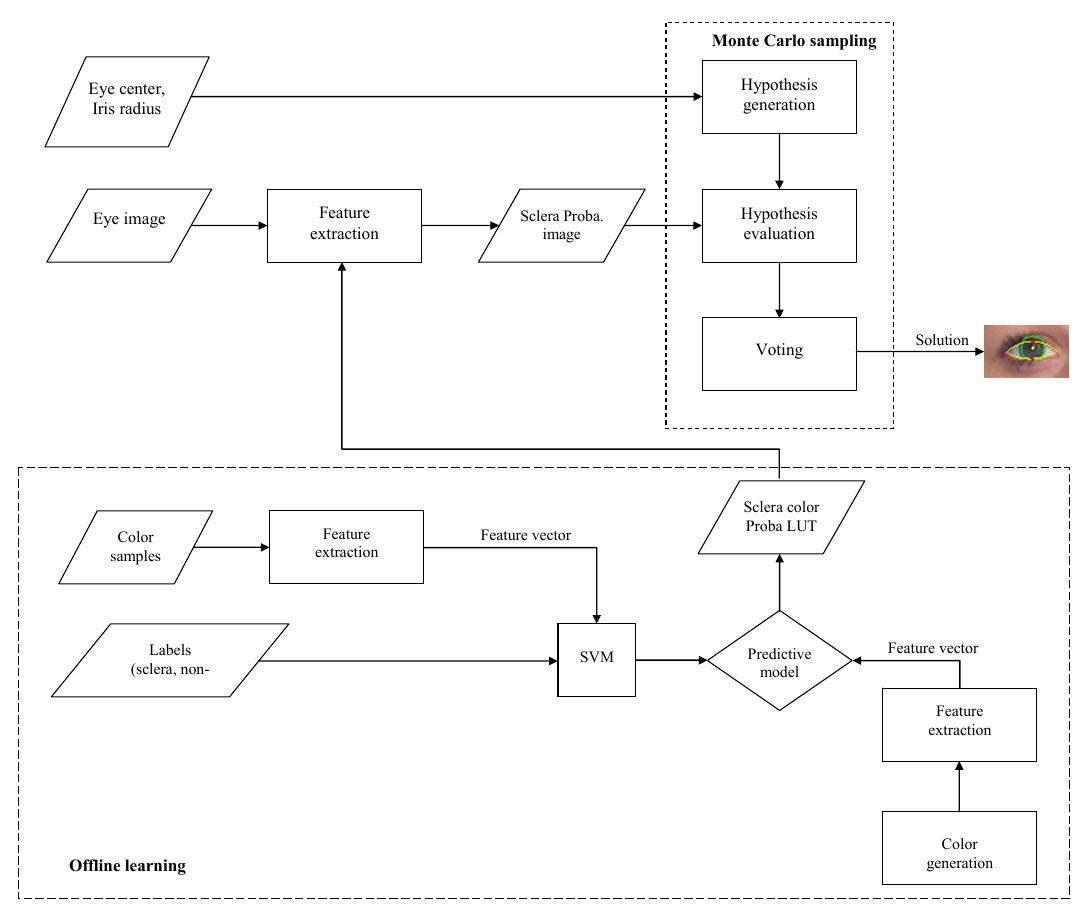
Figure 6. Eye shape detection algorithm.